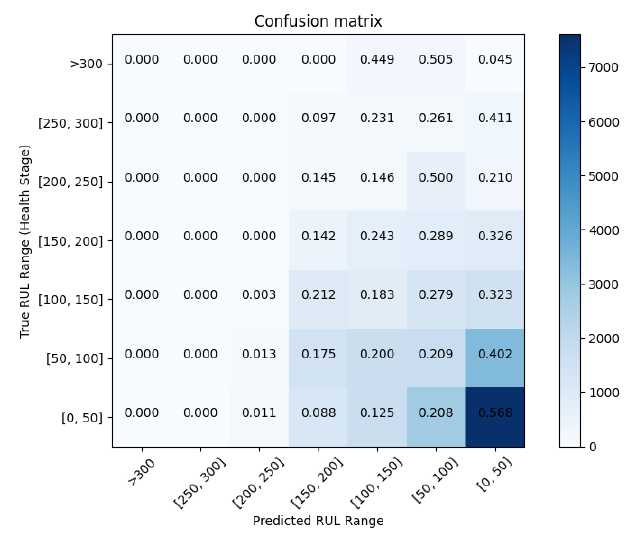
Figure 13. Multiclass confusion matrix. The 7 × 7 confusion matrix allows us to evaluate the performance of the GRU classification model, whereby 7 is the number of target classes.